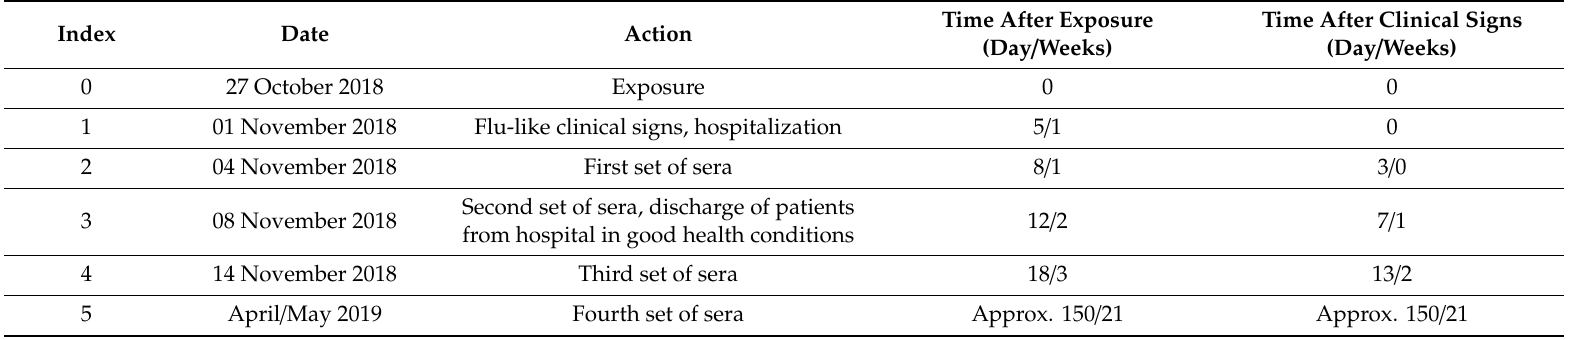
Table 2. Timeline of